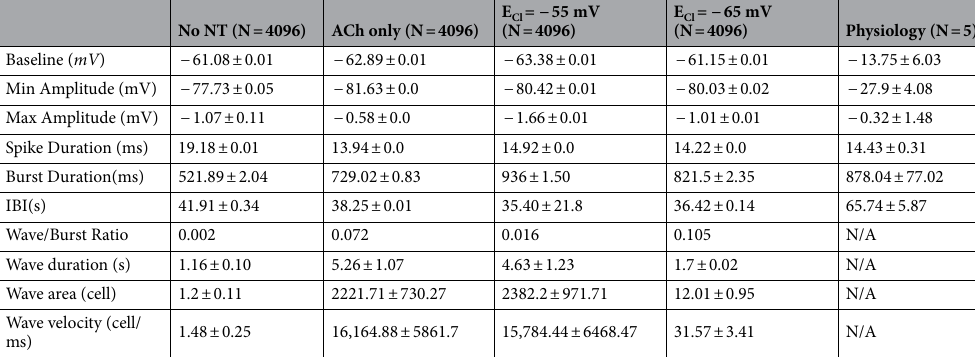
Table 3. Comparison of results between an isolated neuron in a network, a lattice neuron simulation, and physiological data collected via whole cell patch clamp. For modeled data n is equal to the number of simulated cells. For physiological data 1 n is a single whole cell recording. IBI Interburst